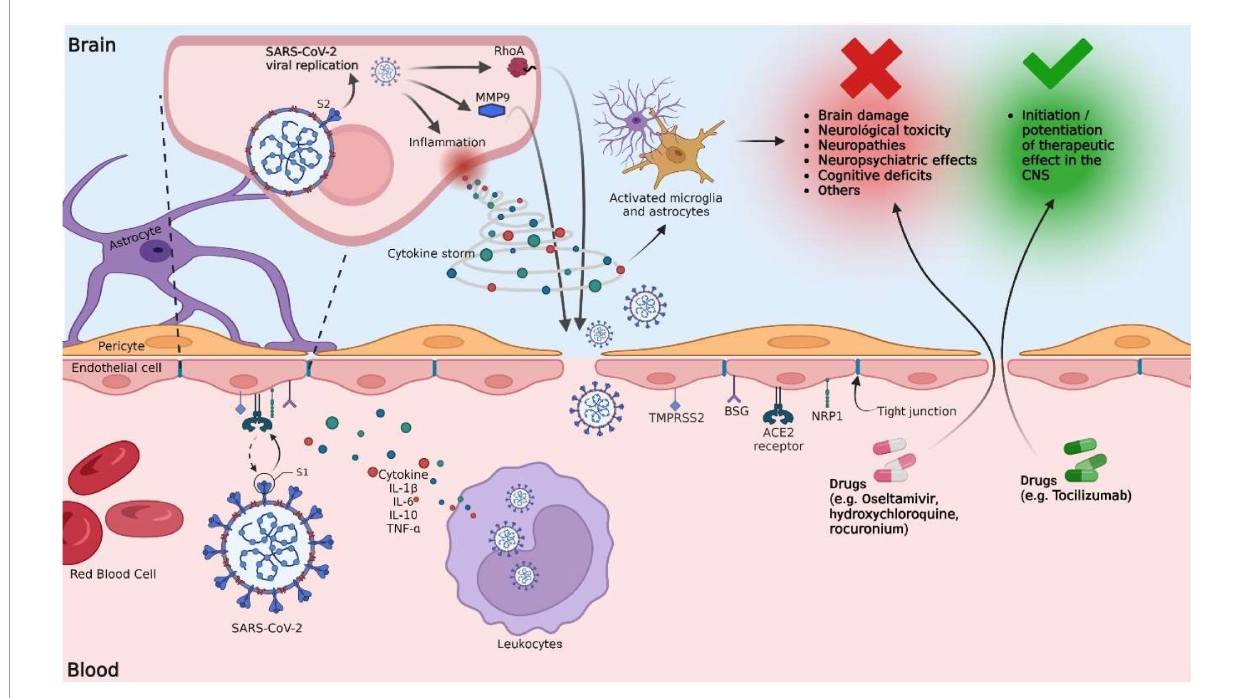
FIGURE1 Potential mechanisms of the blood-brain barrier disruption by SARS-CoV-2 and their implication in the increased permeability of drugs into the brain. SARS-CoV-2 interacts with the BBB by binding the viral S protein and the ACE2 receptors of the vascular endothelium. Other proteins, such as NRP1, TMPRSS2, BSG, and Cathepsin L, are also involved. Proteolytic activation of the S protein is a crucial step in SARS-CoV-2 infection and occurs at the S1/S2 site by the action of furin protease. After binding to ACE2, the S protein undergoes further cleavage mediated by TMPRSS2 at the S2’ site to facilitate the fusion of the virus with the host cell membrane. Once the infection of BBB ECs has occurred, viral replication continues, promoting the activation of inflammatory mechanisms, which include the release of proinflammatory cytokines. The release of primary proinflammatory cytokines, such as IFN- γ and TNF- α , leads to the activation of immune cells, ECs, astrocytes, and microglia. Activated microglial cells induce the release of cytokines such as IL-1, IL-6, and TNF- α , which further activate astrocytes. Activated astrocytes release mediators, such as TNF, prostaglandins, glutamate, ROS, and nitric oxide, which are implicated in neurotoxicity induced by neuroinflammation. IL-6 can cause excessive activation of the complement system and coagulation cascades that contribute to a harmful cytokine storm cycle, destabilizing TJs and damaging BBB ECs, increasing vascular permeability. Lysis of infected ECs alters the permeability of the BBB. The virus promotes an increase in the expression of MMP9 (responsible for the degradation of collagen IV, an essential component of the basal membrane), promoting the rupture of the